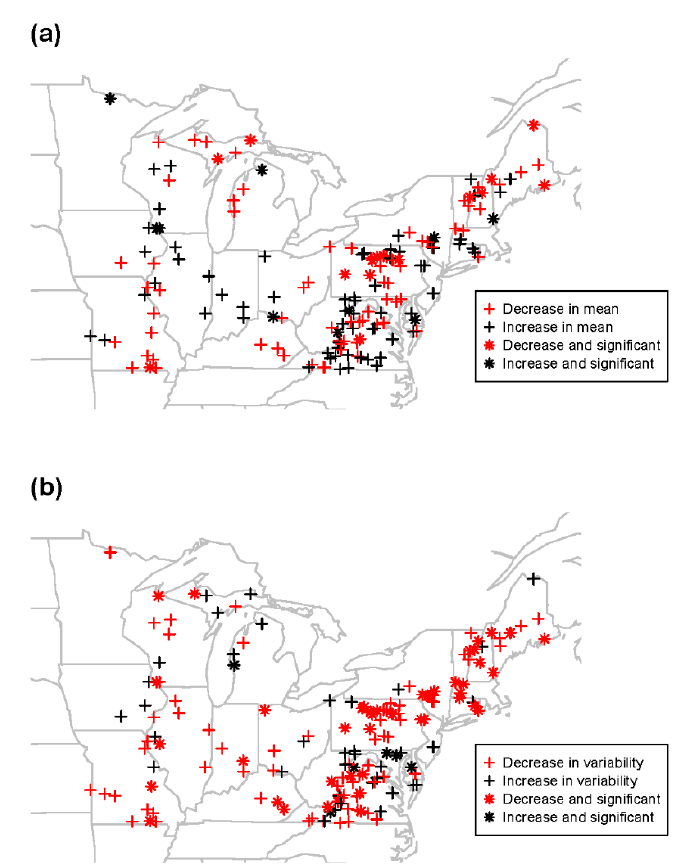
Figure 3. Spatial patterns of changes in seasonality based on circular mean and variability; ( a ) changes in mean annual maximum streamflow (AMF) dates, ( b ) changes in variability (spread) of the AMF dates. The asterisk (*) symbols represent the basins with significant changes.